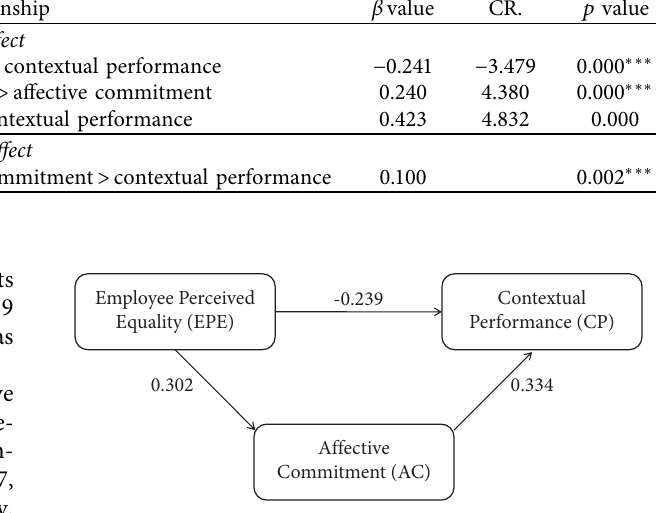
Figure 3: The standardized path coefficients of the structural